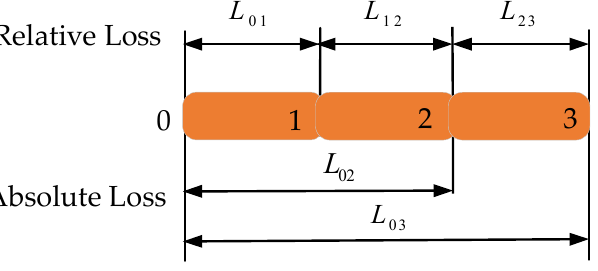
Figure 6. Schematic diagram of the position loss function.